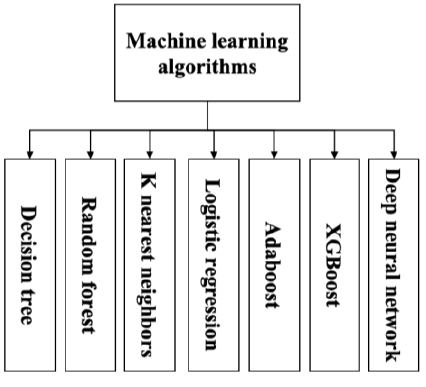
Figure 5. Machine learning algorithms.